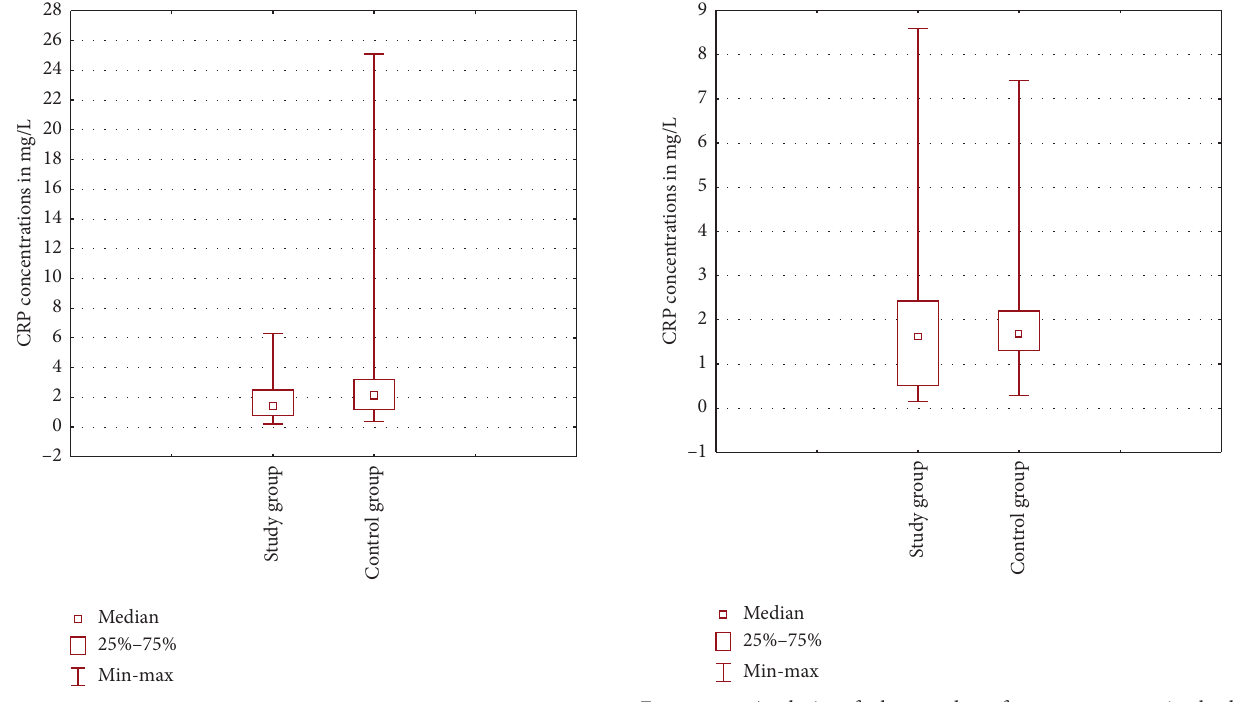
Figure 3: Analysis of the results of measurements in both groups—measurement I.